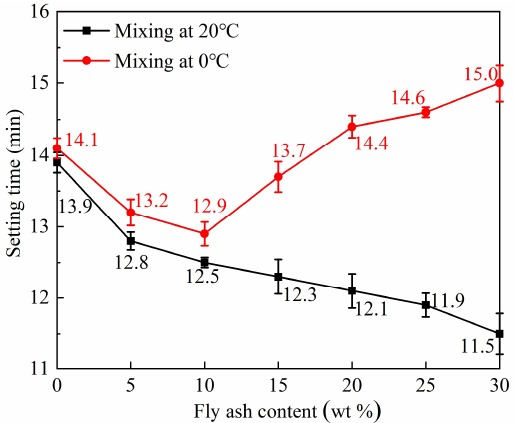
Figure 2. The variation of setting time with mixing temperature and fly ash content